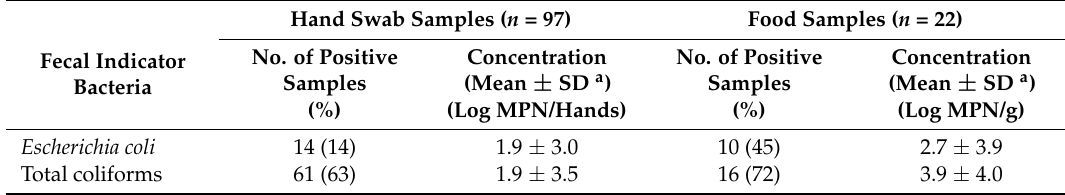
Table 5. Detection of fecal indicator bacteria in hand swab and food